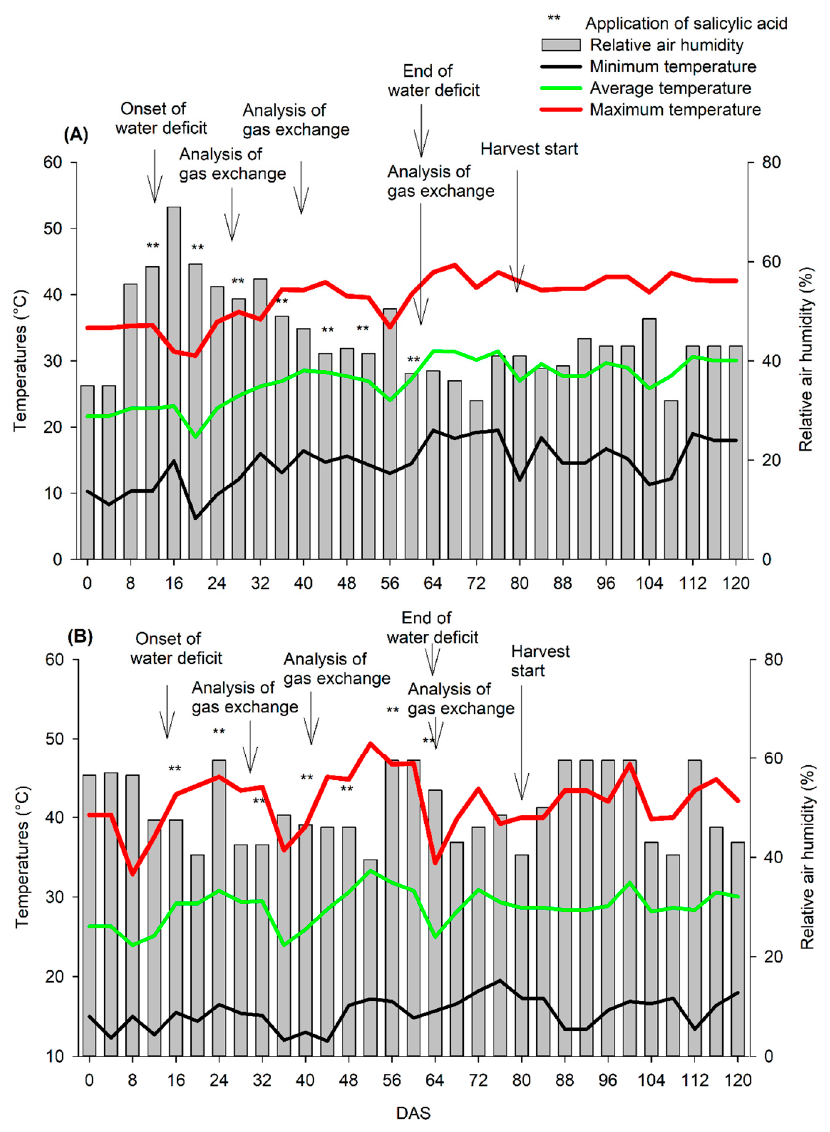
Figure 1. Average, maximum, and minimum temperatures (°C); Relative air humidity (%) inside the greenhouse during 2019 ( A ) and 2020 ( B ) cycles. DAS—Days after sowing.